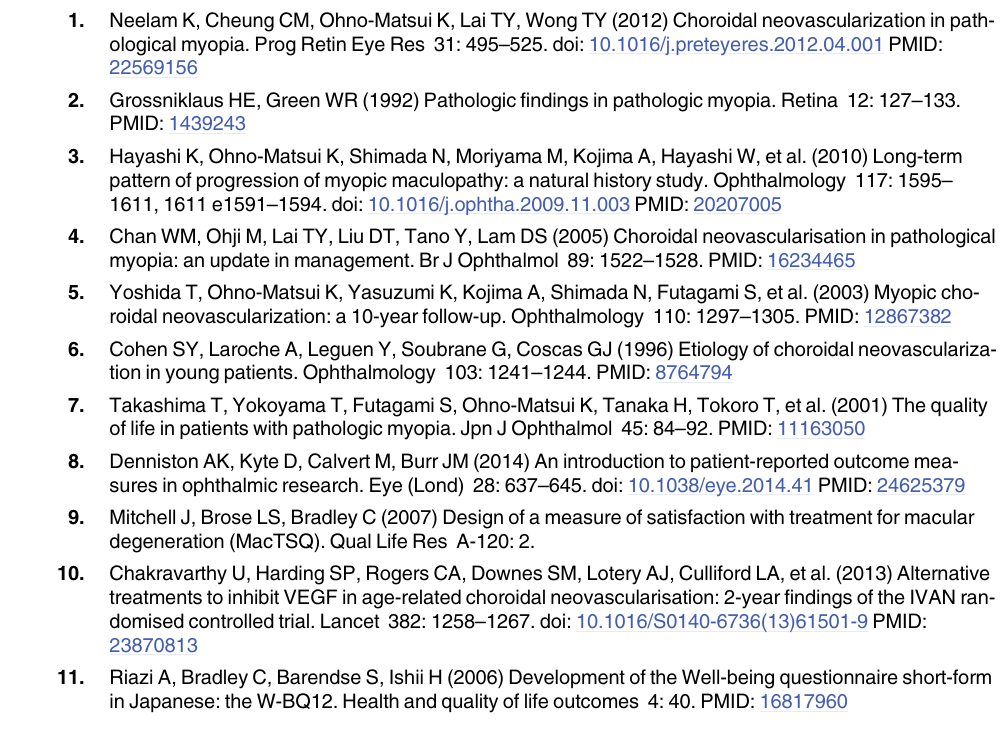
S1 Table. Baseline W-BQ12 scores. S2 Table. Pearson correlations between change in BCVA, MacTSQ scores and W-BQ12 scores. S3 Table. Correlations between change in BCVA and MacTSQ and W-BQ12